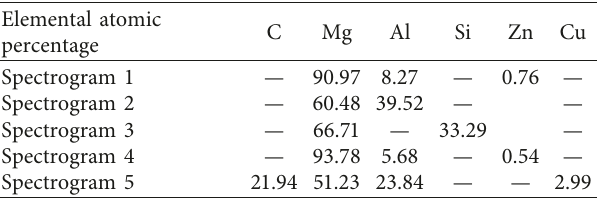
Figure 2: XRD spectrum of Cu-SiC Table 2: AZ91D and Cu-SiC posite element scanning atomic content table.